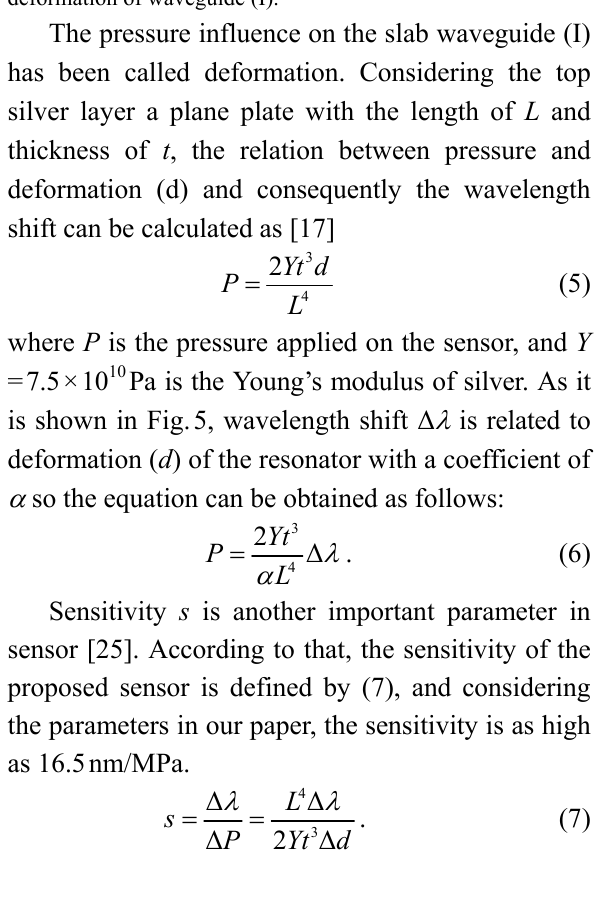
Fig. 5 Resonance wavelength as a function of the deformation of waveguide